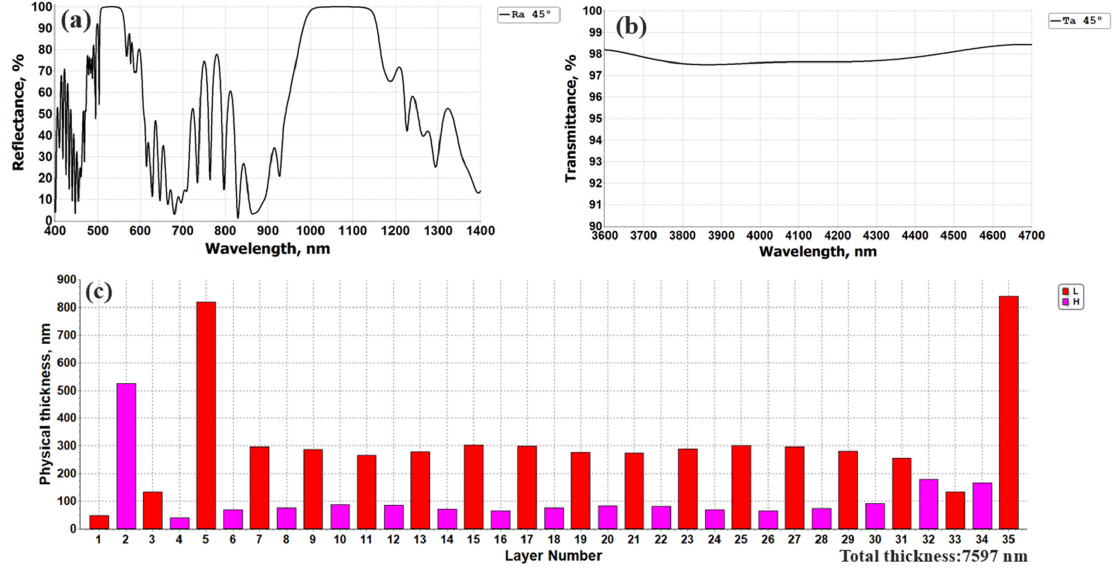
Figure 5. Reflectance at 1064 and 532 nm ( a ), transmittance in the range of 3.6–4.7 um ( b ), and layer-thickness profile ( c ) of the dichroic beamsplitter.